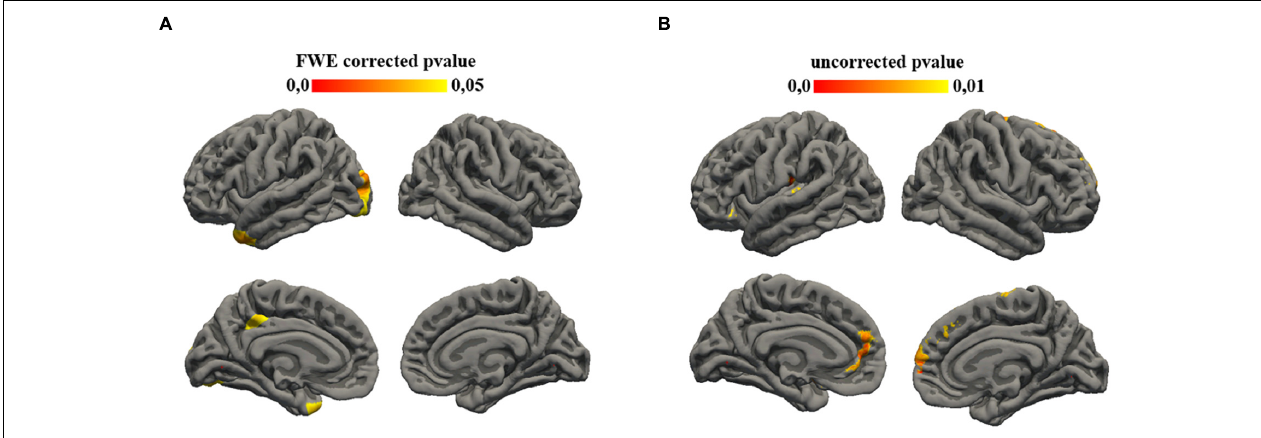
FIGURE 1 | Statistical results mapped on the surface template. (A) Family-wise error (FWE) corrected p -value maps for cortical thickness ADI-social interaction correlation. Significance was set at 0.05. (B) Uncorrected p -value maps for gyrification ADI-social interaction correlation. Significance was set at 0.01.